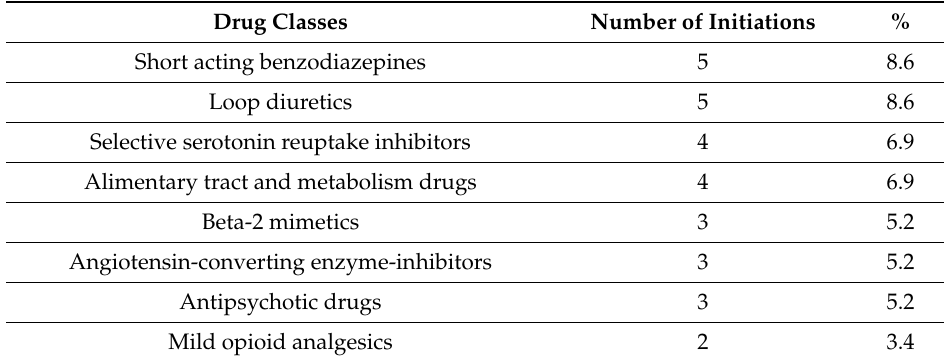
Table 5. Drug initiations 6 weeks after hospital